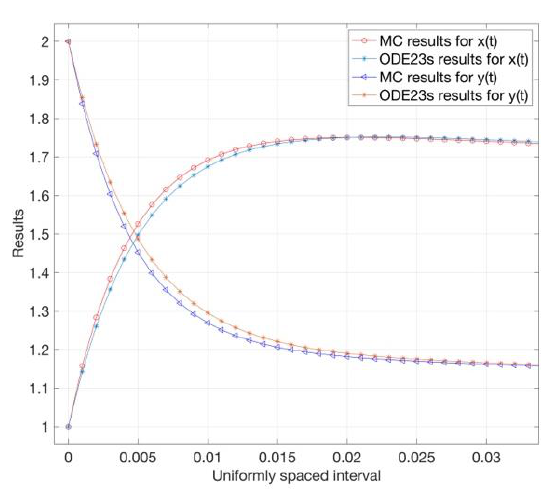
Figure 6. A closer view of Figure 5